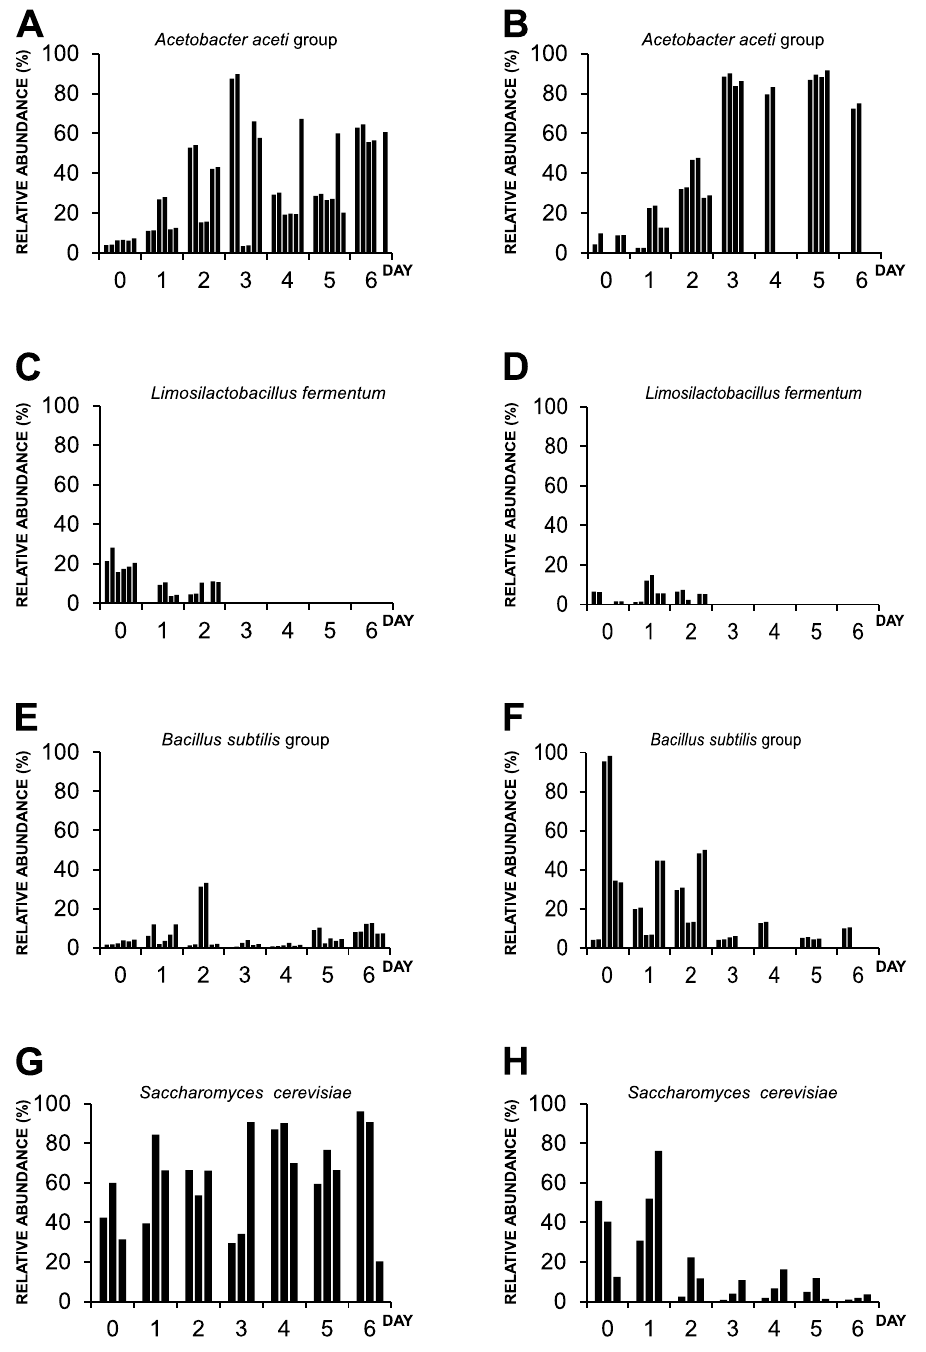
Figure 5. Relative abundance of dominant species of bacteria and fungi from the microorganism’s core during the fermentation of fine flavour cocoa beans at Necoclí ( A , C , E and G ) and Arauca ( B , D , F and H ) farms. Data are shown only for species included in the metabolic model (for remaining species included in the core see Supplementary Fig. S3). Dominant species were defined as species detected all over the replicates and showing a relative abundance higher than 1% from the total number of bacterial or fungal species. Each bar represents a replicate. At least two replicates per day have been